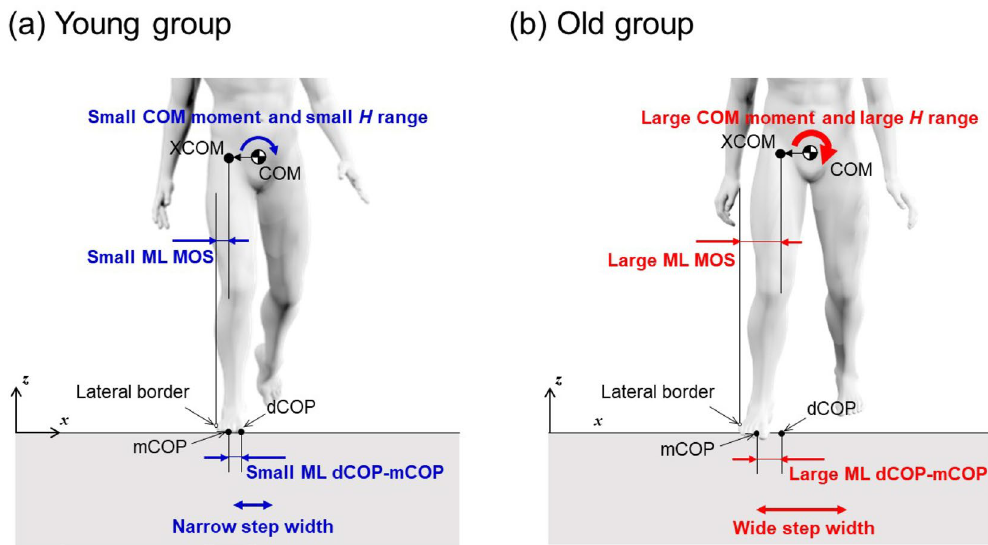
Figure 3. Schematic diagram of the difference in the relation between step width and dynamic balance measures in the ML direction between ( a ) young and ( b ) old groups. ML